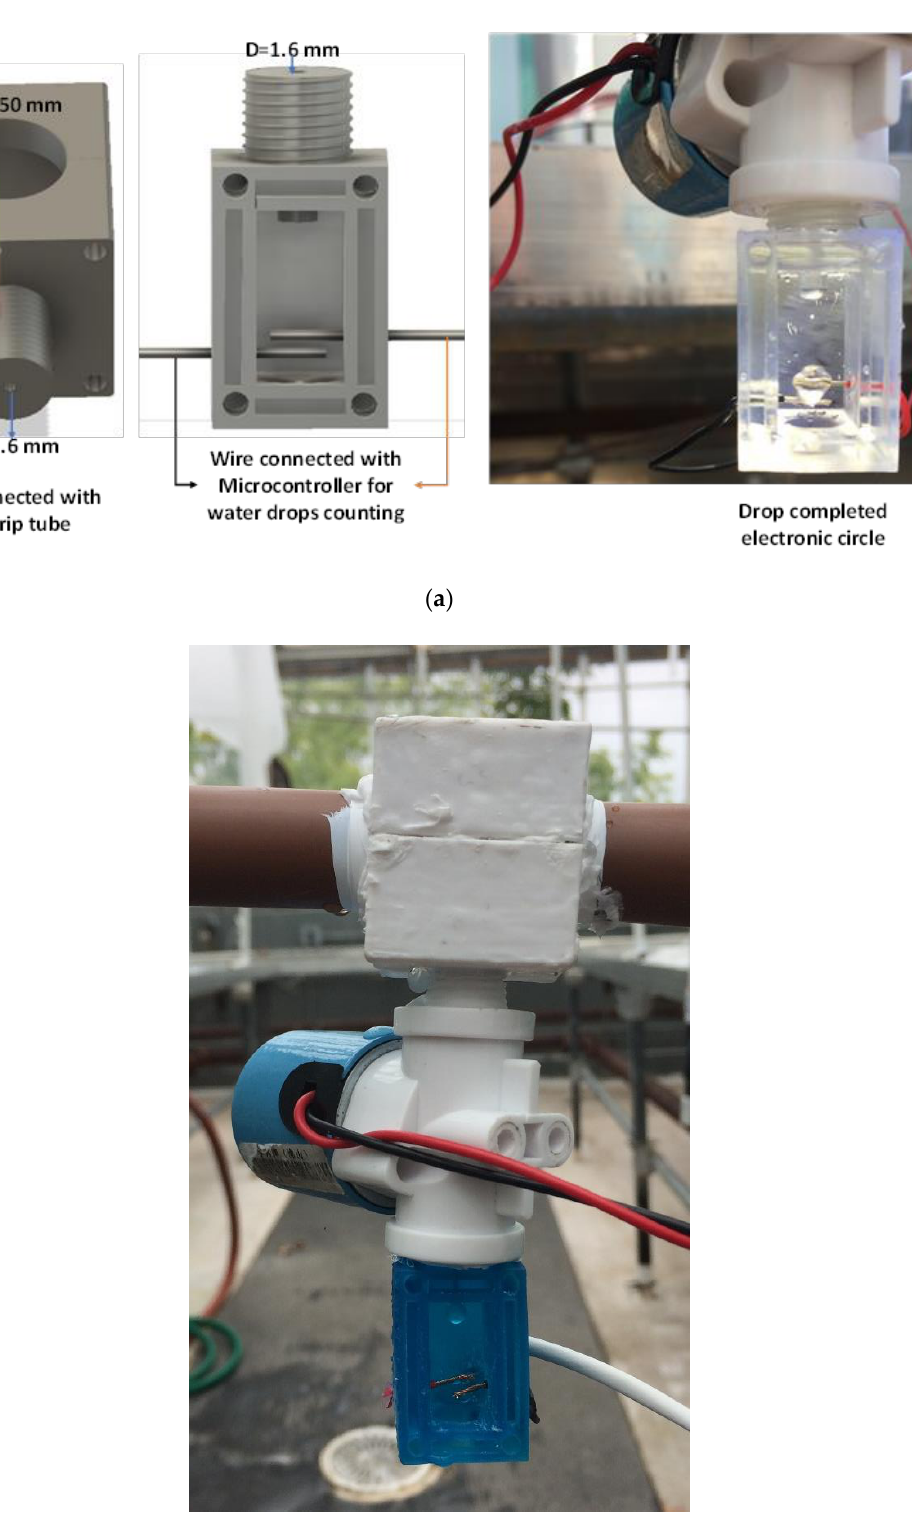
Figure 1. ( a ) New variable rate drip irrigation (VRDI) emitter design shows all the components. ( b ) VRDI drip emitter with 3 mm outer and 1 mm inner diameters. Emitters with all permutations of inner diameter (1 mm, 1.2 mm, 1.4 mm, and 1.6 mm) and outside diameter (3 mm, 3,5 mm, 4 mm, and 4.5 mm) were constructed and tested.